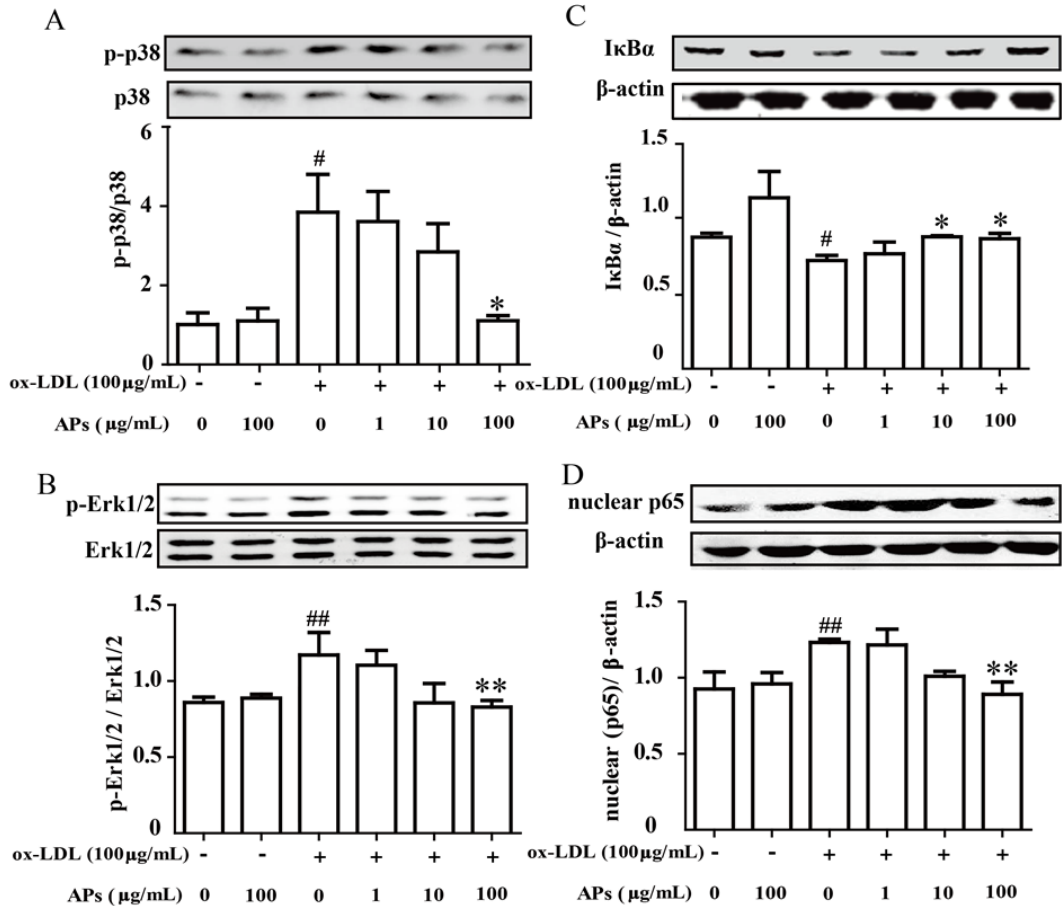
Figure 7. APs inhibit the MAPK and NF-κB activation induced by ox-LDL in RAECs. RAECs were cultured in media with various concentrations of APs for 1 h, followed stimulation with ox-LDL for 30 min to assess the MAP kinase pathway or for 60 min to assess the NF-κB pathway. A and B : Activation of p38 or Erk1/2 was determined by immunoblotting using phosphor-specific (p-) antibodies. Representative blots from three independent experiments are shown. The quantitation of the ratio between phosphorylated protein/total proteins in the cell lysates is shown in the bar graphs; C and D : The nuclear and cytosolic fractions of NF-κB were extracted and then assessed by Western blot. The results are shown as the means ± S.E.M. # p < 0.05, ## p < 0.01 vs. control group. * p < 0.05, ** p < 0.01 vs. ox-LDL alone.